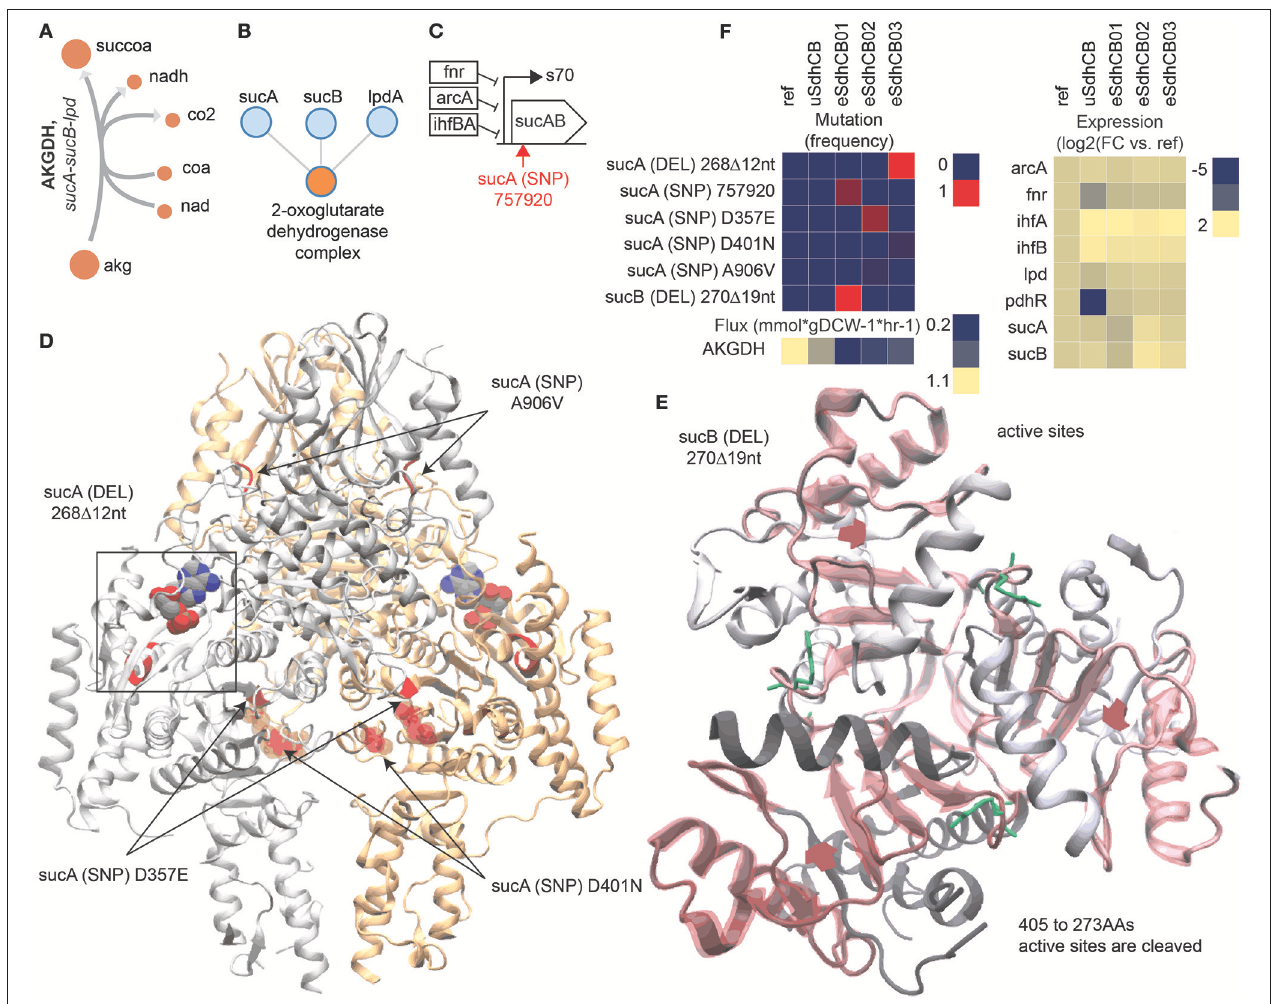
FIGURE 8 | Mutations that affect 2-oxoglutarate Dehydrogenase (AKGDH) enzymatic activity and expression in eSdhCB strains. (A) Network diagram of the AKGDH reaction. (B) Protein-protein binding diagram of the 2-oxoglutarate Dehydrogenase complex formation. (C) Operon diagram of the sucAB operon. The position of the intergenic mutation is highlighted in red. Gene expression of sucAB in eSdhCB01 is significantly depressed compared to all other strains, most likely due to the intergenic mutation ( Table S4 ). In contrast, sucAB is upregulated in eSdhCB02/03 compared to uSdhCB ( Table S4 ). (D) Crystal structure of SucA. Mutations are highlighted in Red. A substrate analog is shown. The deletion (DEL) mutation in eSdhCB03 occurred at residues that affect substrate binding. The sucA D357E, A906V, and D40N SNPs all occur near homodimer interface regions. (E) Crystal structure of SucB. Mutations are highlighted in red. Cleaved regions are outlined in red. Substrate binding residues are highlighted in green. The DEL mutation cleaved residues 405–273, which are all in the active site. (F) Mutation frequency, gene expression levels, and flux of components involved in the AKGDH reaction. Note the reduced flux through AKGDH in all eSdhCB